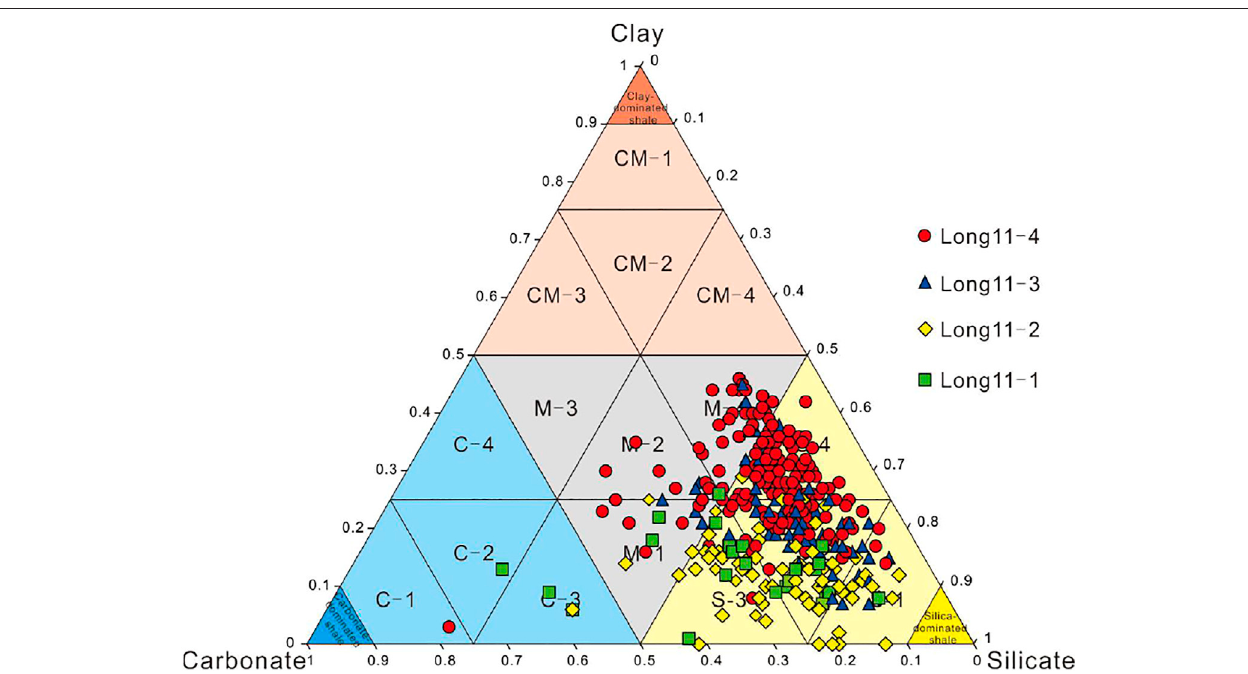
FIGURE 2 | Ternary plot showing the lithofacies types of the Longmaxi Formation in the Changning area (Ternary plot after Wu et al., 2016). M-1: carbonate/ siliceous shale, M-2: mixed shale, M-3: argillaceous/carbonate shale, M-4: argillaceous/siliceous shale, S-1: siliceous shale, S-2: mixed siliceous shale, S-3: carbonate- richsiliceousshale,S-4:clay-richsiliceousshale,C-1:carbonateshale,C-2:mixedcarbonateshale,C-3:silica-richcarbonateshale,C-4:clay-richcarbonateshale,CM- 1: argillaceous shale, CM-2: mixed argillaceous shale, CM-3: carbonate-rich argillaceous shale, CM-4: silica-rich argillaceous shale.